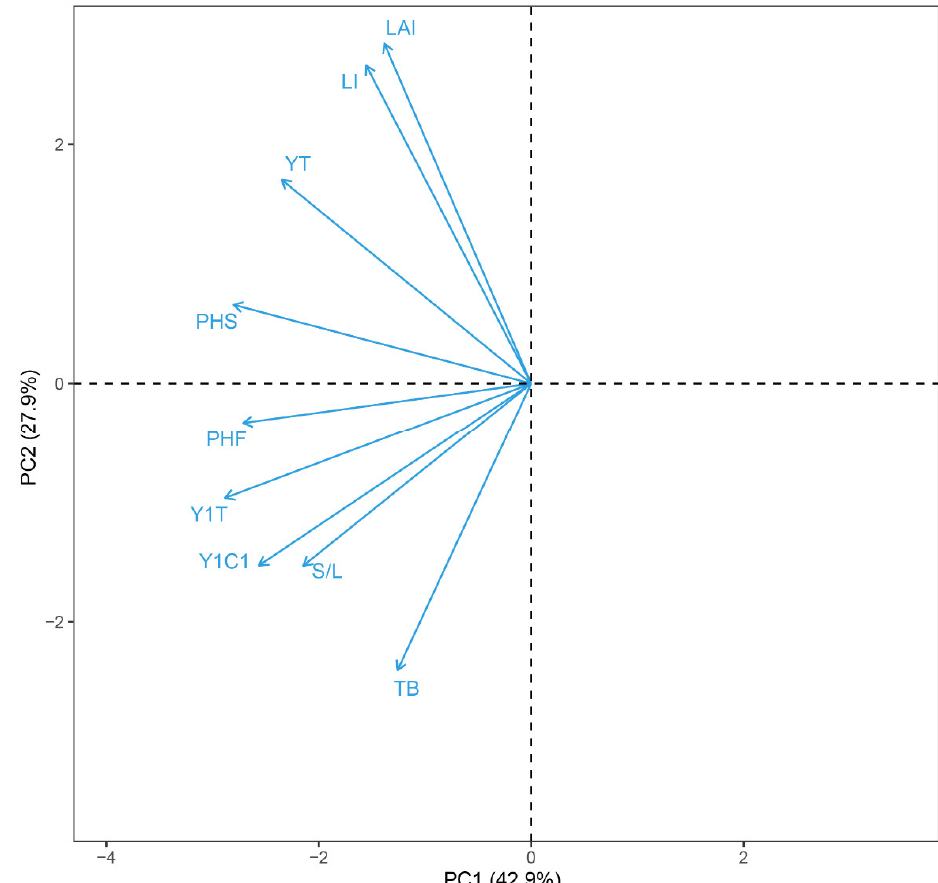
Figure 8. Principal component analysis of alfalfa growth traits and forage yield. PHS: plant height at spring, PHF: plant height at flowering of first cutting, TB: total branch number per plant, LAI: leaf area index, LI: light interception, S/L: stem to leaf ratio, Y1C1: first cutting yield in 2017, Y1T: total yield from four cuttings in 2017, YT: two-year total yield. Table 2. Correlation coefficient matrix among morphological traits of 10 alfalfa varieties.